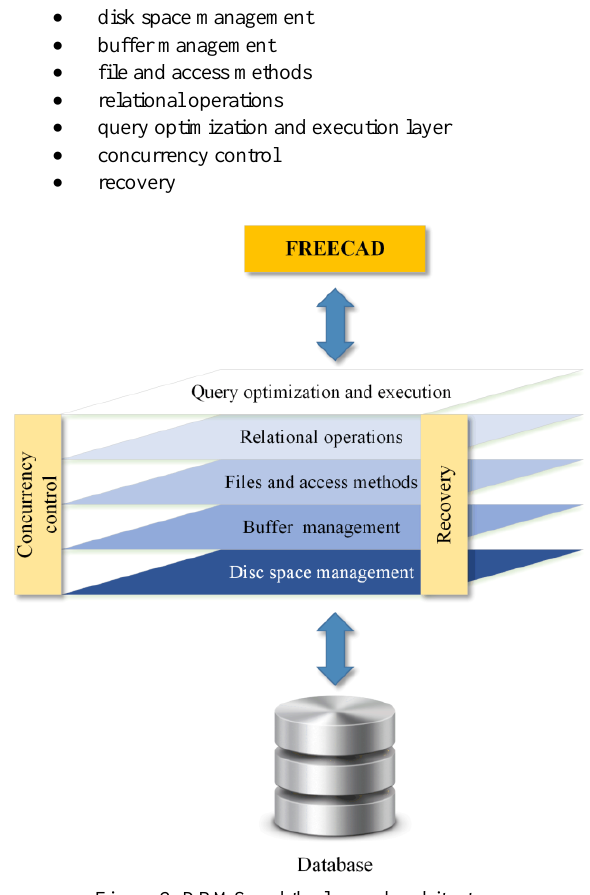
Figure 2: DBMS and the layered architecture